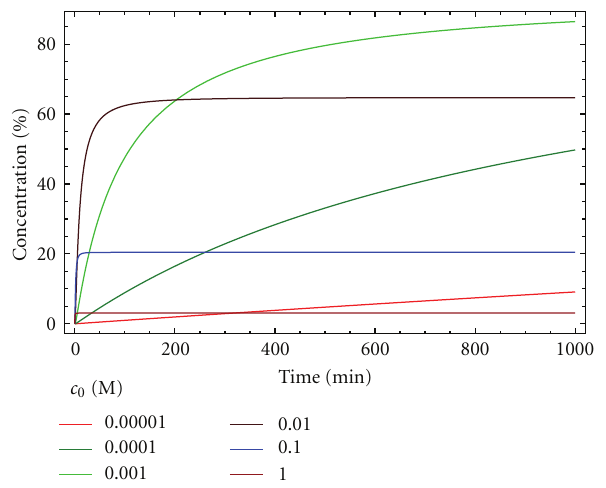
Figure 6: Concentration of the macrocycle D versus time for di ff erent initial concentrations ([A] 0 = [B] 0 = c 0 ) for kinetic model